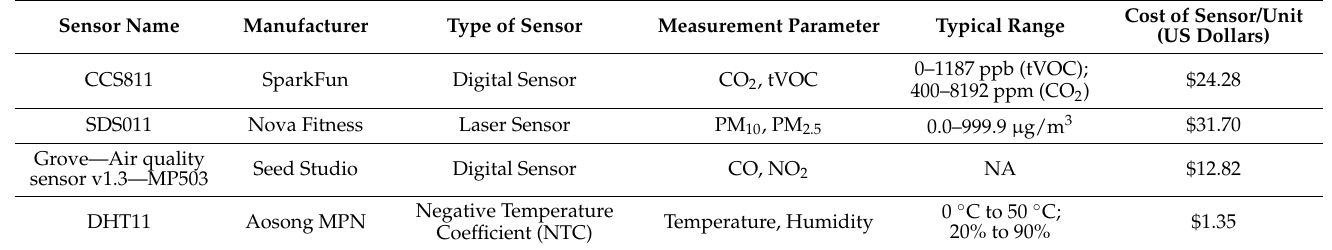
Table 1. Manufacturer specifications for sensors used to design IoT based hardware module.